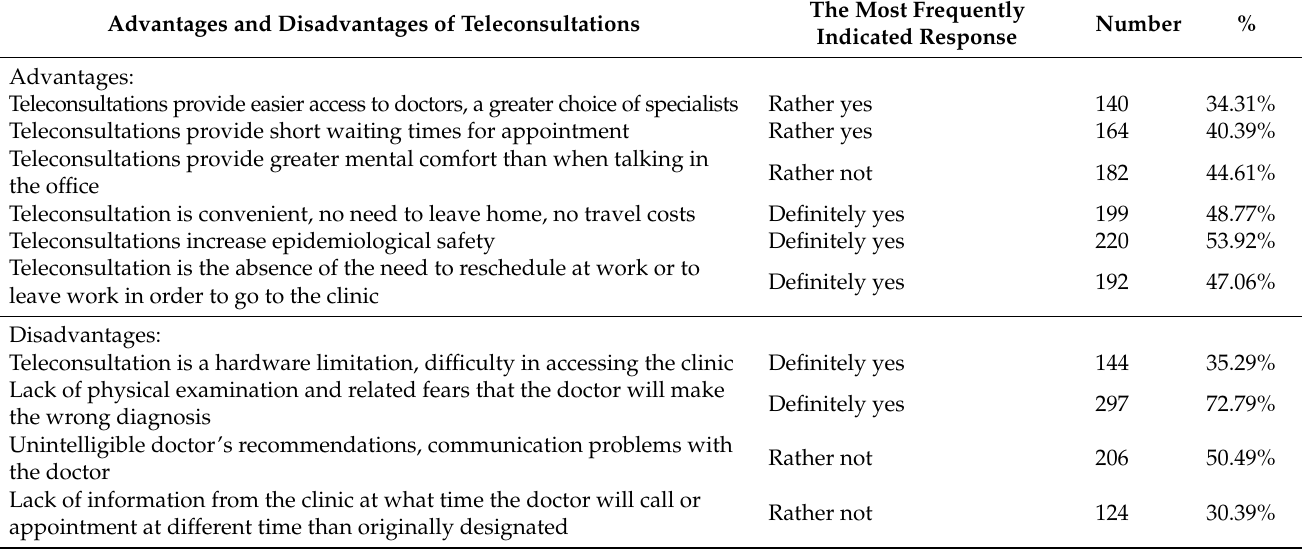
Table 2. Potential advantages and disadvantages of teleconsultations in the opinion of the respondents (number and %).